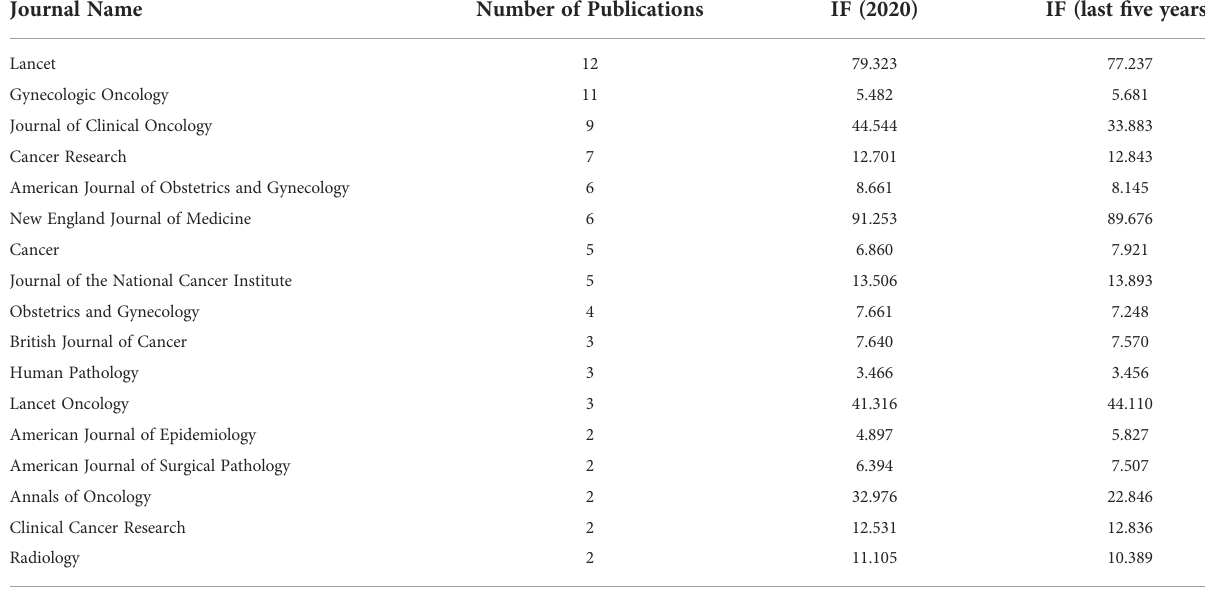
TABLE 1 Journals with more than one paper and their impact factors.